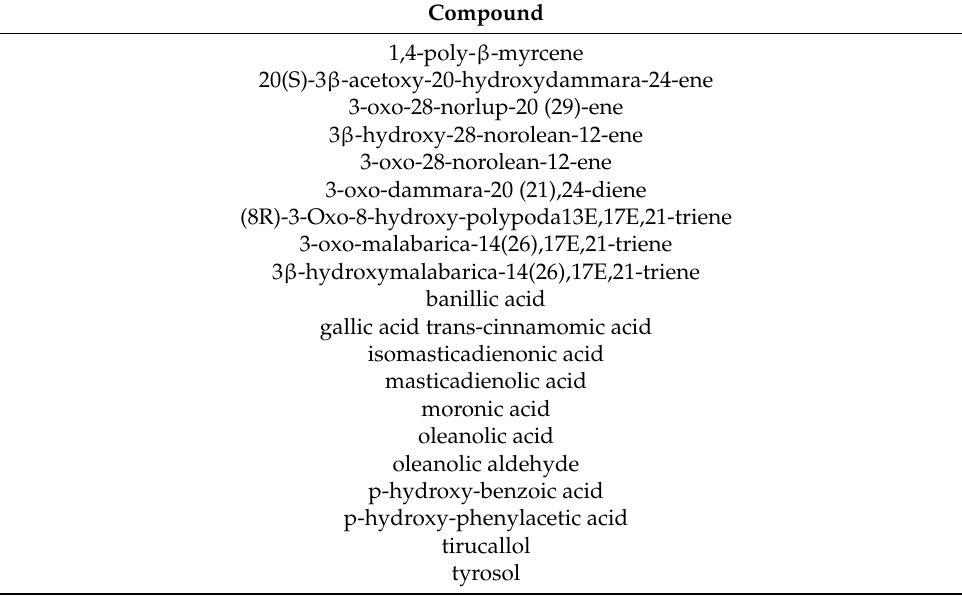
Table 1. Compounds of Chios